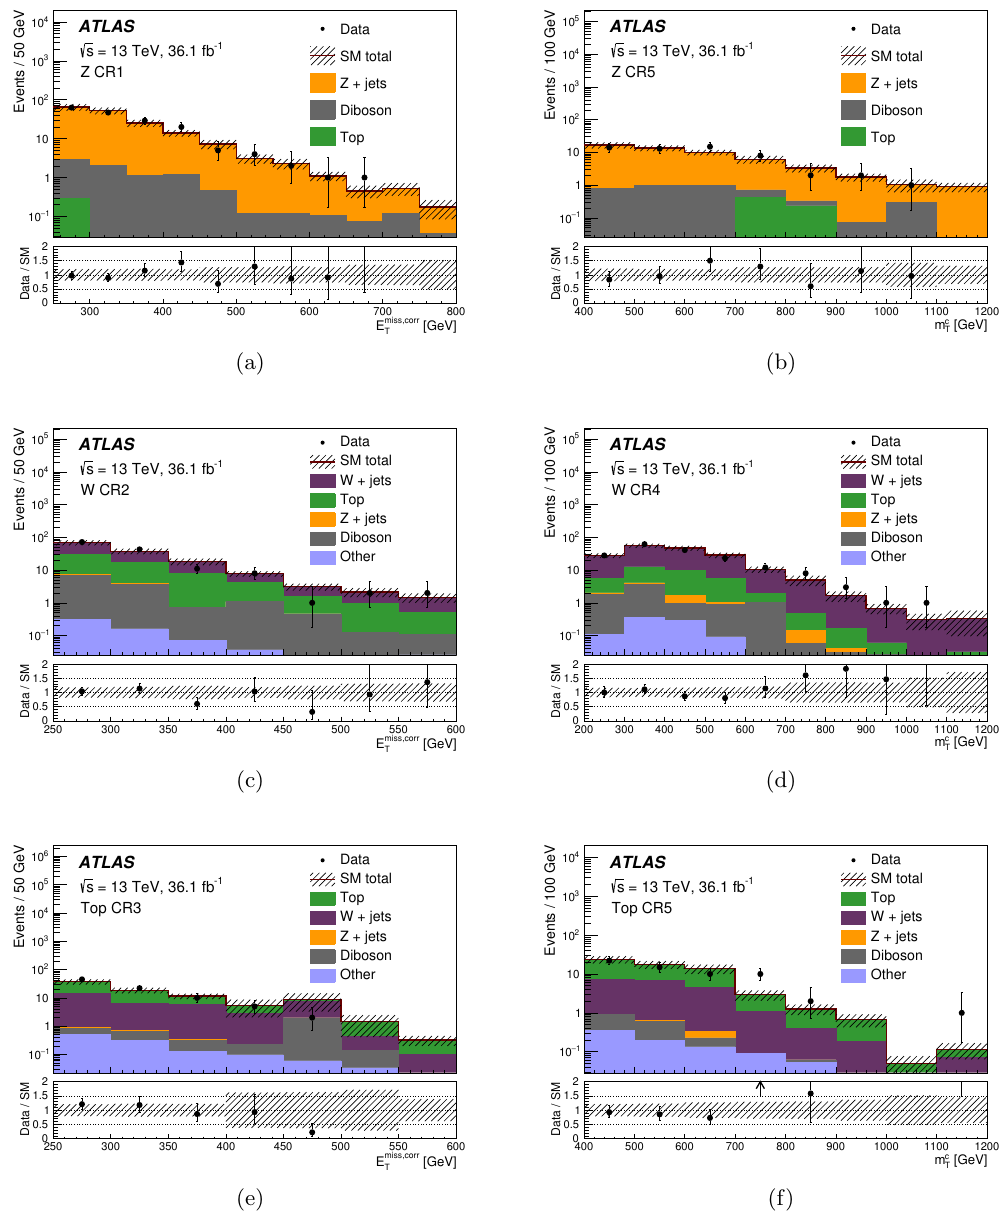
Figure 2 . Examples of comparisons between data and expectation after the background-only (cid:12)t for the E miss,corr distribution (a) Z CR1, (c) W CR2 and (e) Top CR3, and for the m c T (b) Z CR5, (d) W CR4 and (f) Top CR5 . The contributions from all SM backgrounds are shown as a histogram stack. The shaded band indicates the detector-related systematic uncertainties and the statistical uncertainties of the MC samples. The error bars on the data points indicate the data’s statistical uncertainty. The lower panel shows the ratio of the data to the SM prediction after the background-only